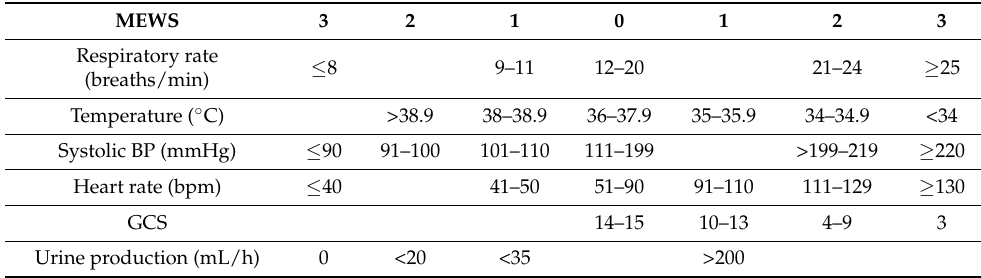
Table 1. MEWS used in our